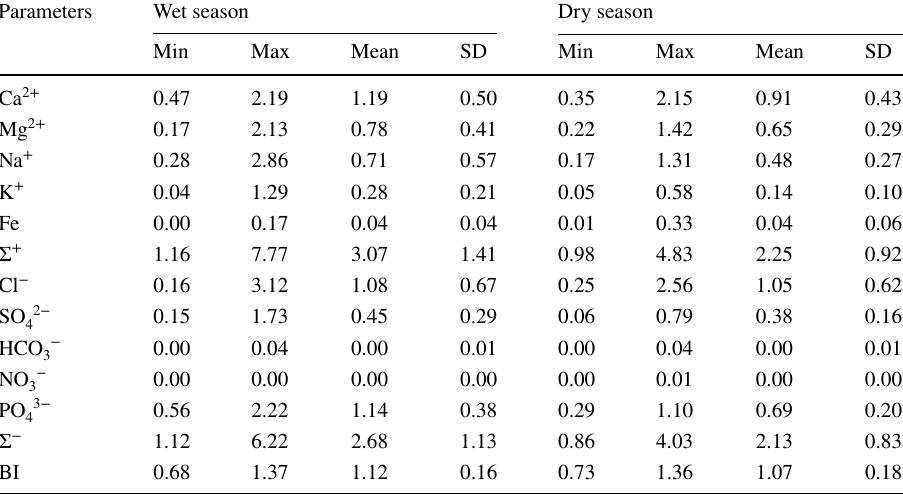
Table 7 Ion balance study for 50 aquifers of the